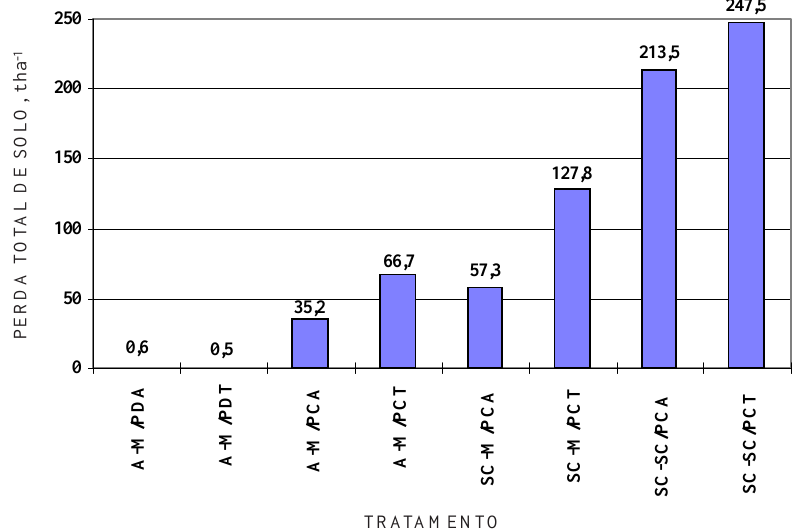
Figura 1. Perda total de solo por erosão, nos quatro testes de chuva simulada realizados na cultura do milho, nos tratamentos estudados (A-M = aveia-milho; SC-M = sem cobertura-milho; SC-SC = sem cobertura-sem cobertura; PDA = plantio direto tração animal; PDT = plantio direto tratorizado; PCA = preparo convencional tração animal; PCT = preparo convencional tratorizado).